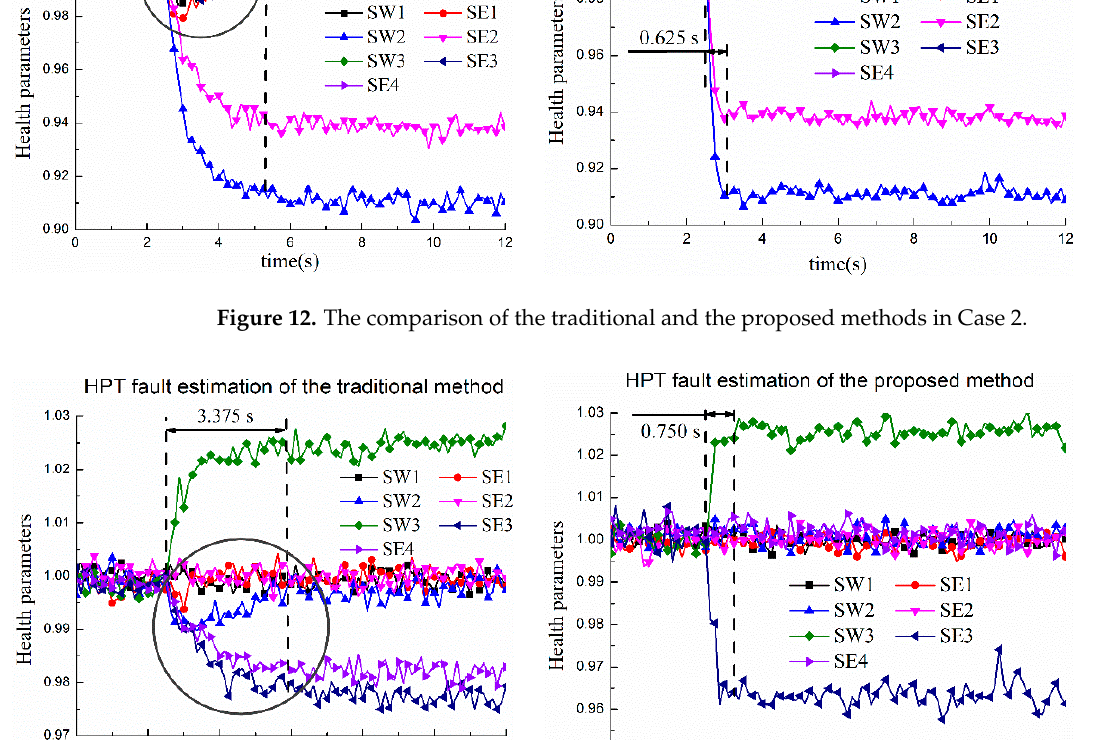
Figure 13. The comparison of the traditional and the proposed methods in Case 3.